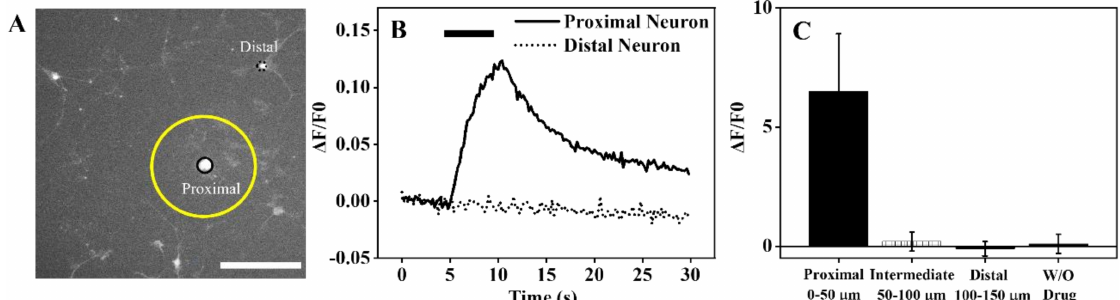
Figure 4. ( A ) Fluorescent calcium imaging of neuron activities upon electrically stimulated GLU released from microwire coated with PEDOT/SNP(GLU). Yellow circle indicates the position of drug releasing site on microwire, black solid circle labels a proximal neuron and dash circle labels a distal neuron, scale bar is 100 µ m. ( B ) Fluorescence intensity changes of the two example neurons in ( A ) upon electrically stimulated GLU release, horizontal line indicates the stimulation duration. Image capture rate was 200 ms/frame for 30s. ( C ) Maximum intensity change of neurons averaged from three separate cultures at different distances, as well as the electrical control group, where empty PEDOT/SNP electrodes were stimulated. No Ca 2+ change was observed when electrodes were 50 µ m away or without GLU loading.